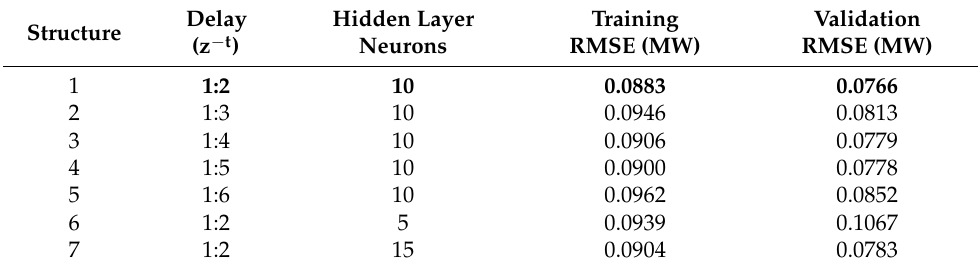
Table 4. RNNs analyzed structures’ averaged results for fixing hidden layer’s number of neurons.